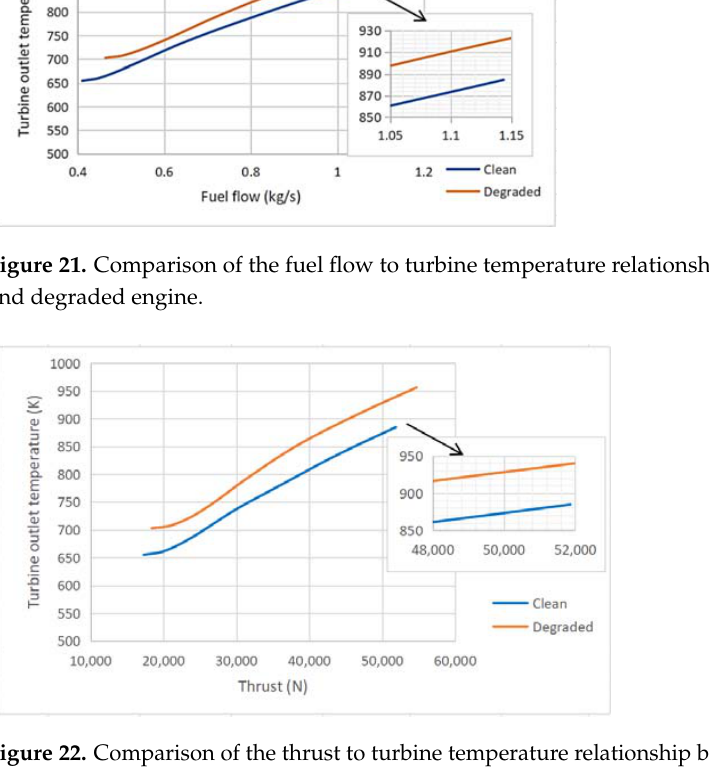
Figure 22. Comparison of the thrust to turbine temperature relationship between a clean engine and degraded engine.